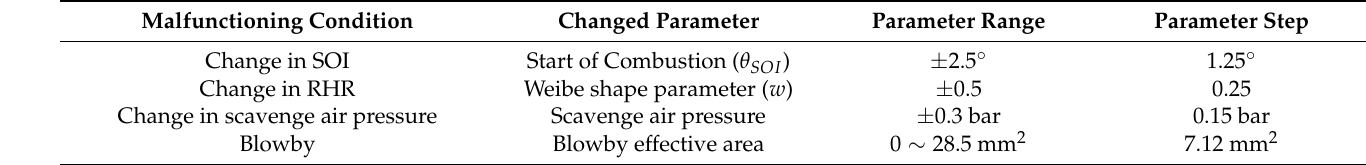
Table 2. Malfunctioning condition parameters